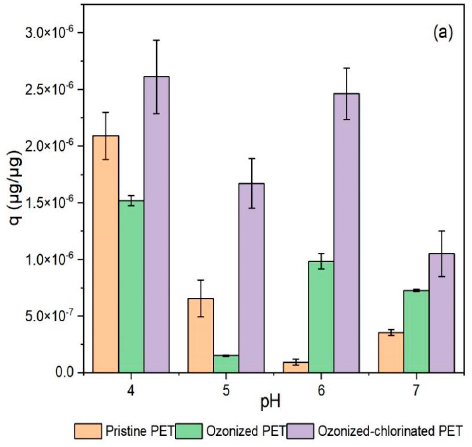
Figure 9. The influence of ( a ) pH, ( b ) kind of anion, ( c ) kind of cation, ( d ) humic acid concentration, ( e ) anion surfactant concentration on TBM sorption to PET with the different oxidation processes. The initial concentration of TBM was 10 μ g/L. All the adsorption experiments were conducted at pH = 7 and 20 °C. 2.3.2. Effects of Inorganic Ions There are various inorganic ions in the natural aquatic environment. They can affect the adsorption capacity of PET by changing the charge on its surface. The effect of four cations and four anions on the adsorption of TBM on pristine and oxidized PETs is shown in Figure 9a,b. For pristine PET, the adsorption of TBM with NO 3 − , SO 42 − , HCO 3 − , Na + /Cl − , Ca 2+ , Mg 2+ , and Fe 3+ decreased by 73.1%, 76.2%, 61.9%, 77.8%, 73%, 76.9%, and 75.5%,